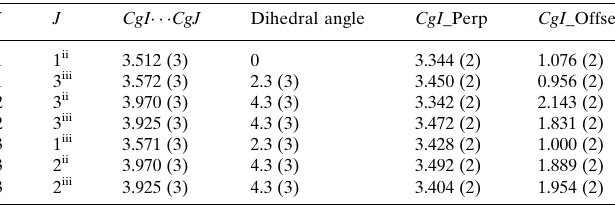
Table 2 (cid:3) – (cid:3) interactions (A˚ , (cid:3) ). Cg 1, Cg 2 and Cg 3 are the centroids of the O3/C7–C10/C15, C10–C15 and C1– C6 rings, respectively. CgI (cid:2)(cid:2)(cid:2) CgJ is the distance between ring centroids. The dihedral angle is that between the planes of the rings I and J. CgI _Perp is the perpendicuar distance of CgI from ring J. CgI _Offset is the distance between CgI and the perpendicular projection of CgJ on ring I